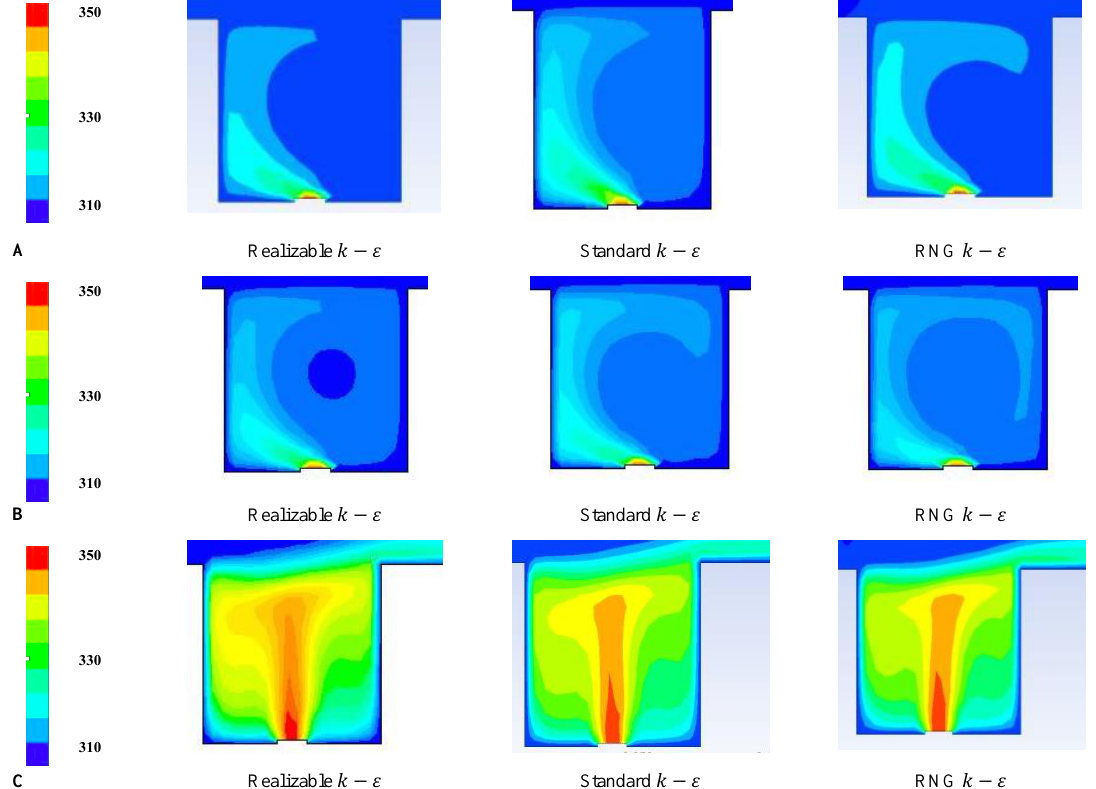
Fig. 2. The temperature distributions within the street canyon (AR=1) under different turbulence models. (A: Qe = 4 l/h and Uw=2 m/s; B: Qe = 4 l/h and Uw=4 m/s; C: Qe = 40 l/h and Uw=2